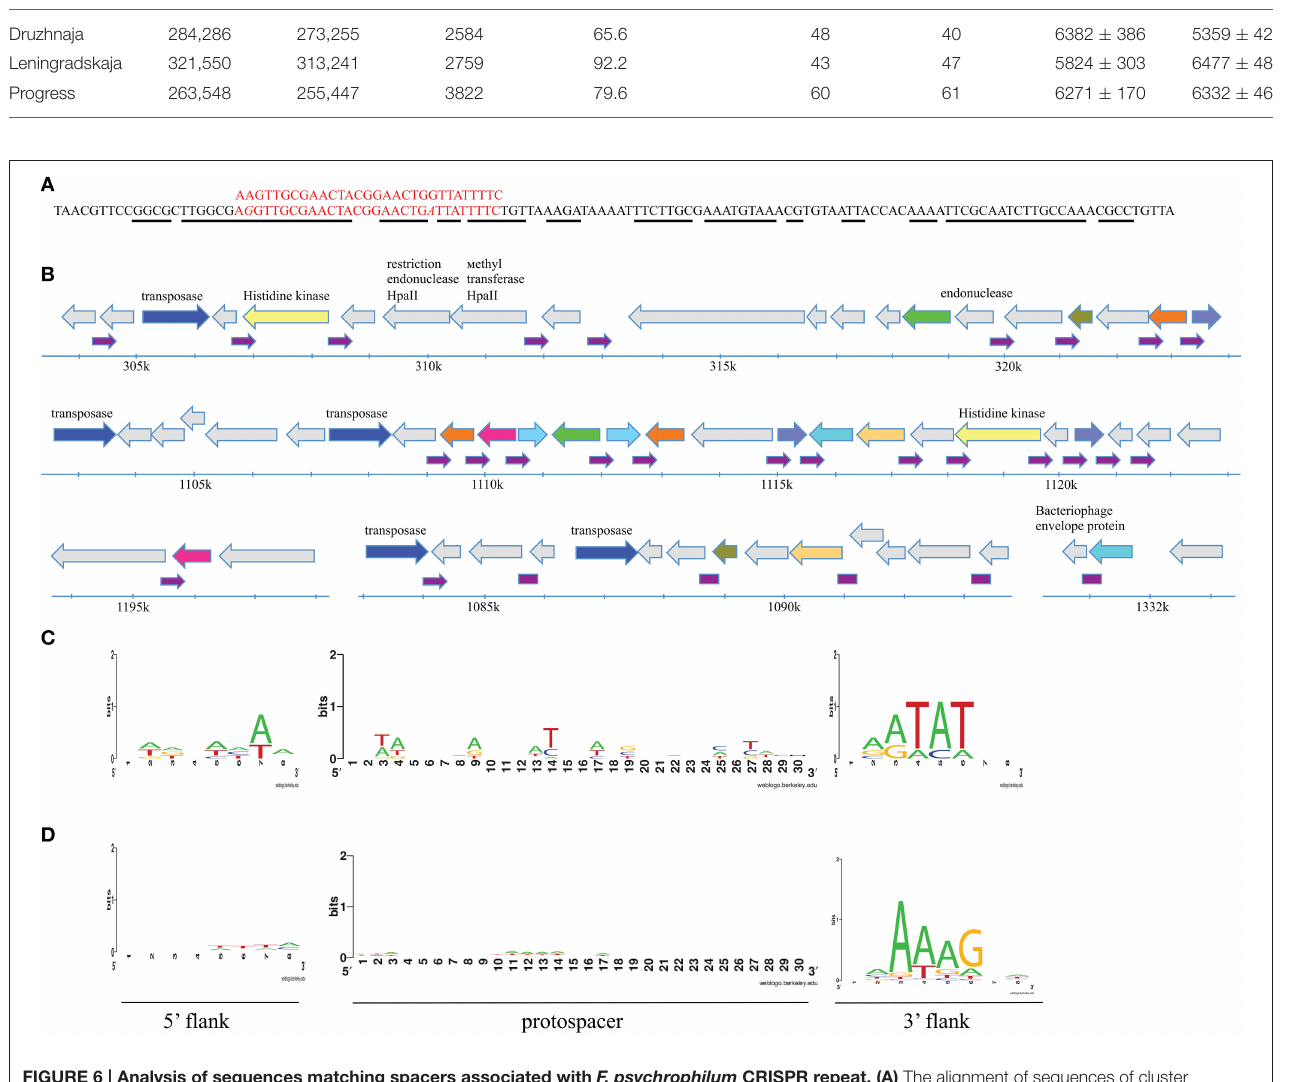
FIGURE 6 | Analysis of sequences matching spacers associated with F. psychrophilum CRISPR repeat. (A) The alignment of sequences of cluster consensus and 125 bp-long repeat. The aligned nucleotide positions are shown in red. Nucleotide positions in 125 bp-long repeat that participate in secondary structure formation of the transcript are underlined with a black line. (B) At the top, the sequence of a non-coding 125 bp-long imperfect palindromic repeat and matching F. psychrophilum spacer are shown. The distribution and genetic neighborhoods of 30 125 bp-long repeats in regions of Flavobacterium indicum genome is shown below. The repeats are indicated by small purple arrows. Genes are shown as arrows. Unlabeled gray arrows correspond to unique open reading frames with unknown function. Unique open reading frames with predicted functions are also shown in gray with annotations. Arrows marked with the same (non-gray) color correspond to genes encoding homologous proteins (more than 80% identity) of unknown function. Genes coding for IS110 family transposes are shown in blue. (C) A LOGO showing the results of alignment of 12 flavophage protospacers and their 8-bp flanking regions matching CRISPR spacers from F. psychrophilum genomes deposited in the GenBank. (D) As in (C) but showing the results of alignment of 511 sequences from Antarctic metagenomic matching Antarctic F. psychrophilum CRISPR